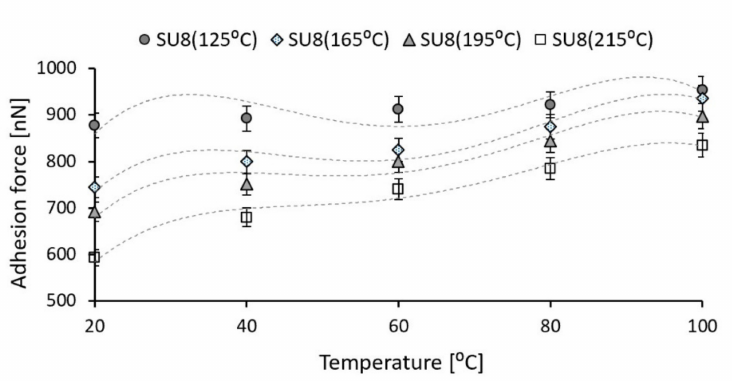
Figure 9. Experimental variation of adhesion force between AFM tip (Si) and SU-8 as a function of the testing temperature (error amount percentage less to